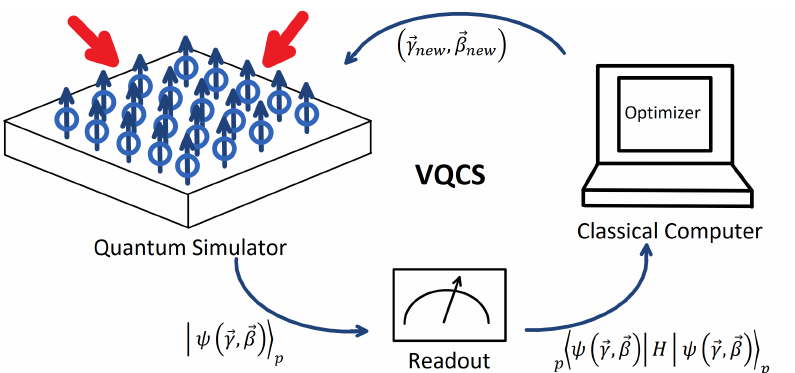
Figure 1: Schematic depiction of the hybrid variational quantum-classical simula- tion (VQCS) used to target non-trivial quantum states. A quantum simulator of e.g. trapped ions is used to unitarily prepare a target state | ψ ( γ , β ) 〉 tocol (5) using a set of variational angles ( γ , β ) of some fixed number of itera- tions p . A cost function, for e.g. the global energy of some target Hamiltonian 〈 ψ ( γ , β ) | H | ψ ( γ , β ) 〉 H , is then measured (achievable due to single-site resolu- T p T p tion in measurements of quantum simulators). The result is then fed into a classical computer, which finds the next set of angles that optimizes the cost function. The simulation terminates when the cost function is desirably optimized; the resulting quantum state is then the near to the target